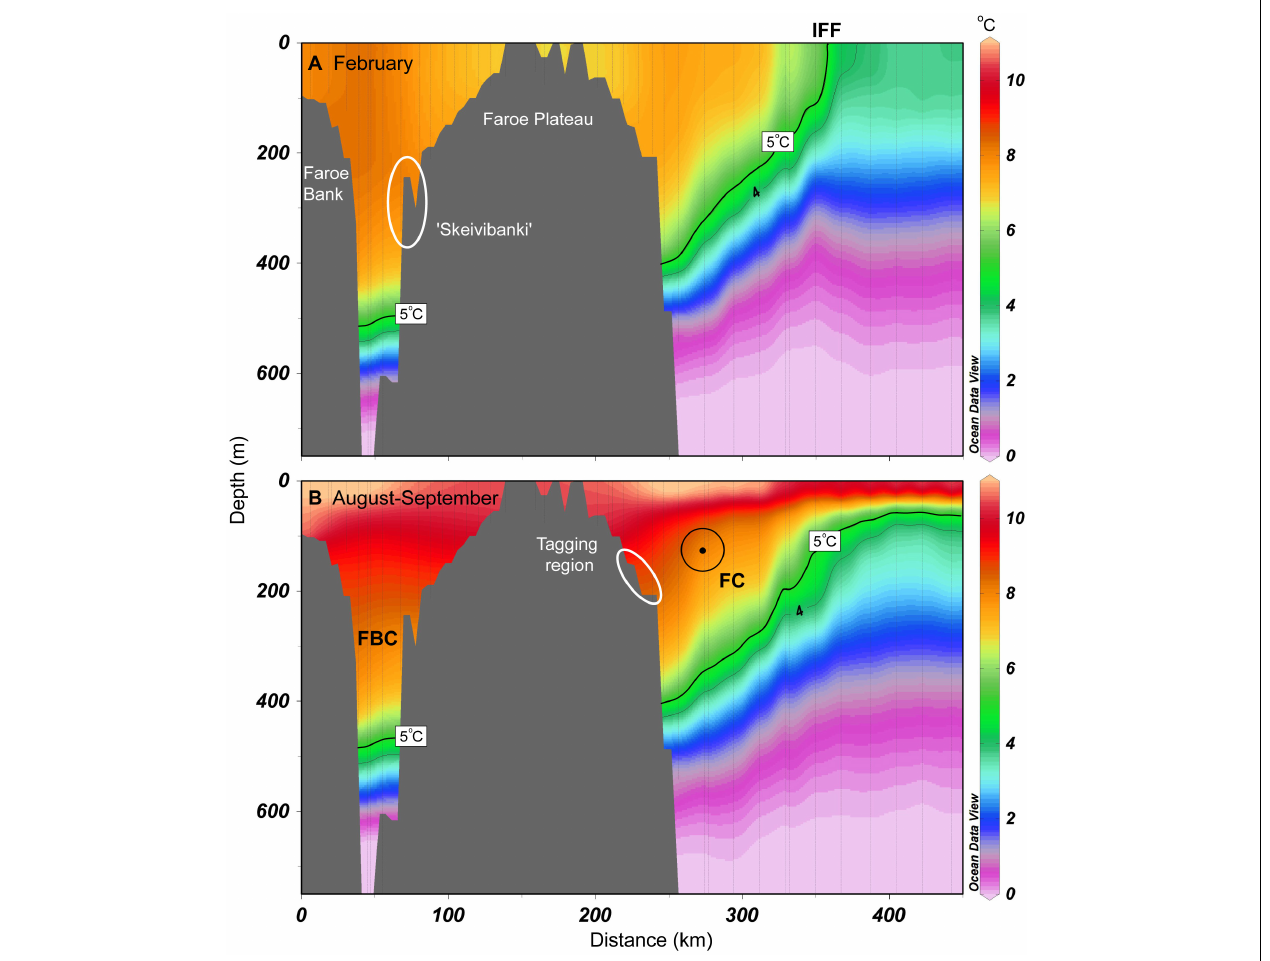
FIGURE 7 | Average temperature sections (2013–2018) from the Faroe Bank, across the Faroe Plateau and following Section N toward north during (A) February and (B) late August/early September. The 5 ◦ C isotherm (and weakly the 4 ◦ C) is emphasized with black lines. This illustrates the lower tolerance of anglerfish, and it also coincides with the main interface between the upper MNAW and the underlying cold overflow source waters. Ovals show the spawning region near “Skeivibanki” (A) and the tagging region (B) . FBC, Faroe Bank Channel; IFF, Iceland-Faroe Front; FC, Faroe Current (directed out of the